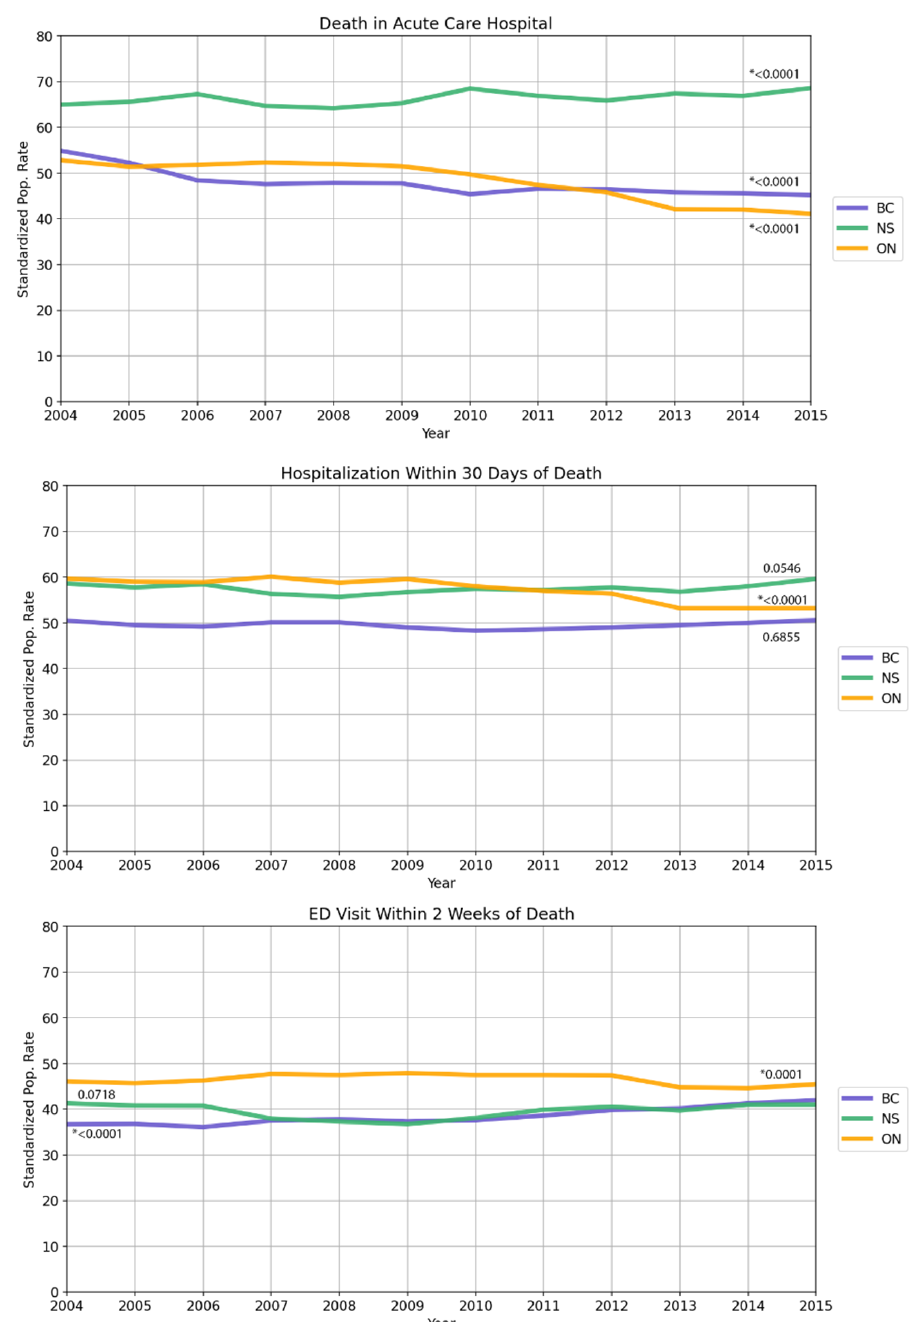
Figure 1. Death in acute care hospital ( top ), new hospitalizations within 30 days of death ( middle ), and one or more ED visits within 2 weeks of death ( bottom ) data over time from 2004 to 2015. In terms of death experienced in an acute care hospital, Ontario saw the greatest decrease, from 52.8% in 2004 to 41.1% in 2015. Ontario experienced the largest amount of change in hospitalizations within 30 days of death, decreasing from 59.7% in 2004 to 53.2% in 2015. Emergency room visits within 2 weeks of death stayed the same for Ontario and Nova Scotia, while British Columbia experienced an increase from 2004 to 2015. p -values reported are from the Cochran–Armitage trend test (two-sided); * denotes values that are statistically significant.